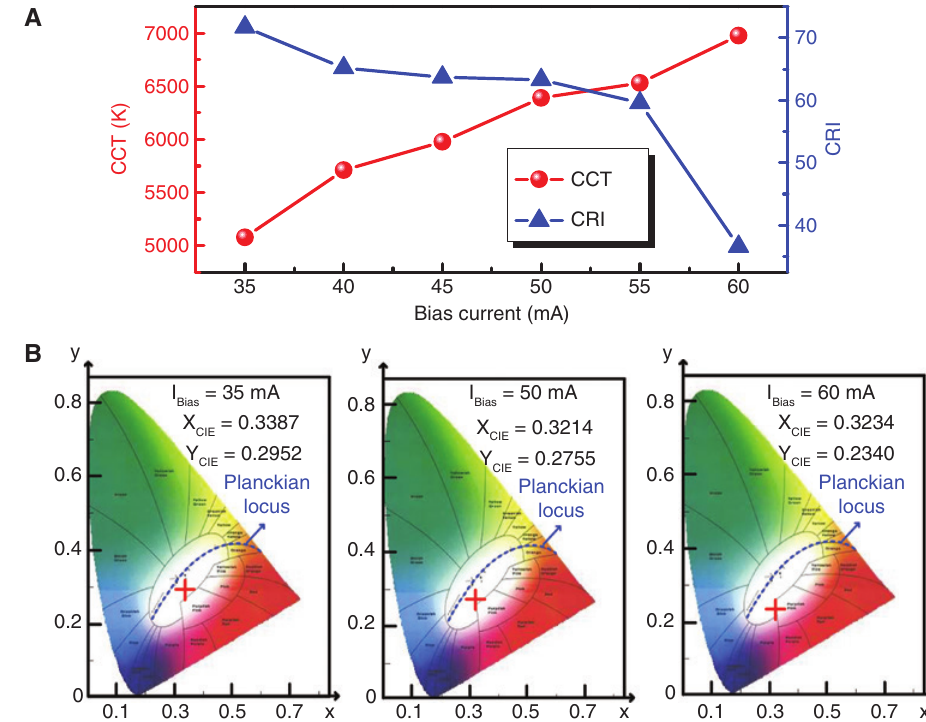
Figure 6: The quality of the VLD + CdSe/ZnS core-shell-QD phosphor mixed white light. (A) CCTs and CRIs of VLD + CdSe/ZnS core-shell-QD based white-lighting source at different bias currents; (B) CIE coordinates of VLD + CdSe/ ZnS core-shell-QDs based white-lighting source biased at 35, 50, and 60